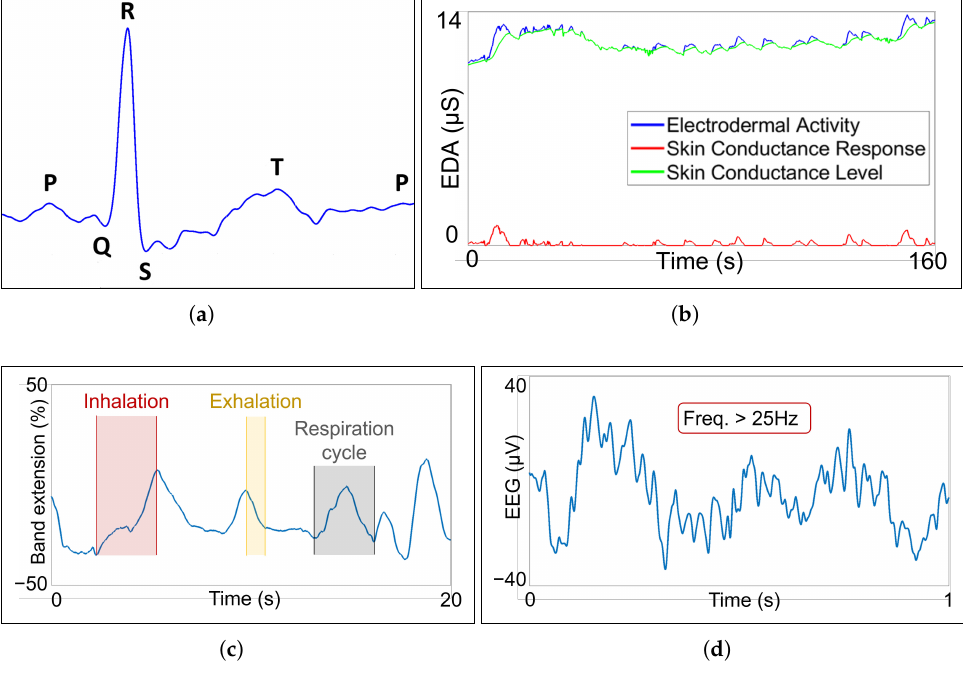
Figure 2. Measured bio-signals: ( a ) ECG with characteristic points: P, Q, R, S and T; ( b ) EDA with skin conductance response and skin conductance level components; ( c ) PZT signal with one inhalation, one exhalation and one complete respiration cycle highlighted; ( d ) gamma wave EEG signal, with a frequency higher than 25